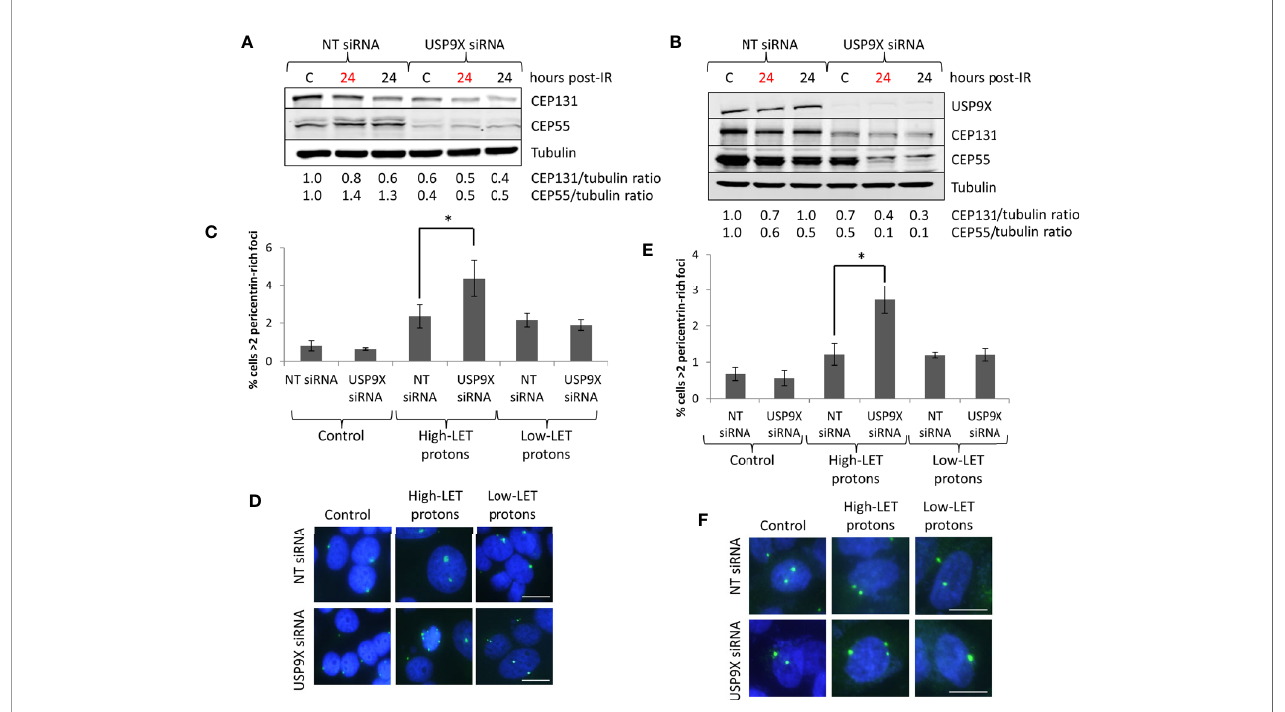
FIGURE 6 | USP9X depletion destabilizes centrosomal proteins, and induces pericentrin-rich foci ampli fi cation in response to relatively high-LET protons. (A, C, D) HeLa or (B, E, F) UMSCC74A cells were treated with USP9X or a non-targeting (NT) control siRNA for 48 h, and unirradiated designated (C) or irradiated with 4 Gy relatively high-LET or low-LET protons and allowed to repair for the time points indicated post-irradiation. (A, B) Whole cell extracts were analyzed by immunoblotting using the indicated antibodies. Red and black text refers to time post-irradiation following relatively high-LET and low-LET protons, respectively. Protein levels of CEP131 and CEP55 relative to tubulin and normalized to the unirradiated NT siRNA control treated cells which was set to 1.0 are shown. (C, E) Analysis of pericentrin was performed by immuno fl uorescence 48 h post-irradiation. Shown is the mean percentage of cells with >2 pericentrin-rich foci/nucleus ± S.D. *p < 0.03 as analyzed by a two-sample t -test. (D, F) Representative images of pericentrin staining (green stain) and nuclei (blue stain;